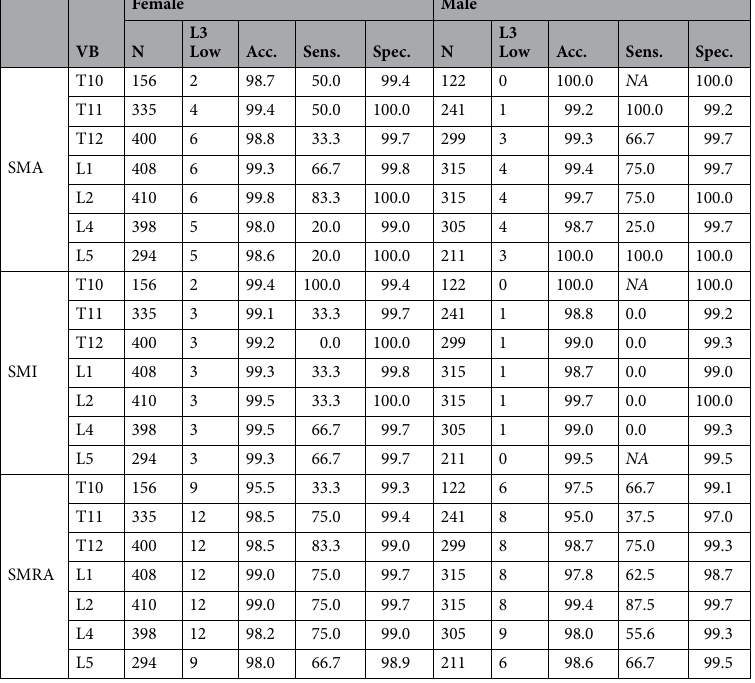
Table 3. Accuracy of binary cutoffs by vertebra level and sex using the L3 classifier as reference. (L3 Low = the number of reference cases classified as “low”, e.g., L3 value below the L3 cutoff. Acc. = Overall accuracy. Sens. = sensitivity. Spec. =